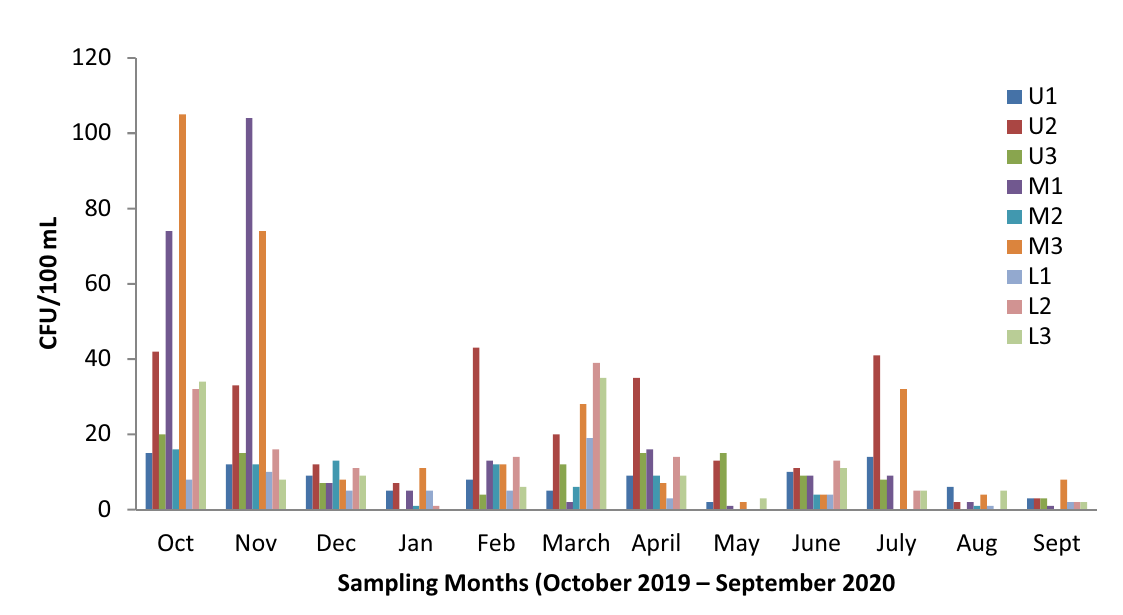
Fig. 4 Monthly variation of Enterococci counts across stations during the study period (October 2019–September